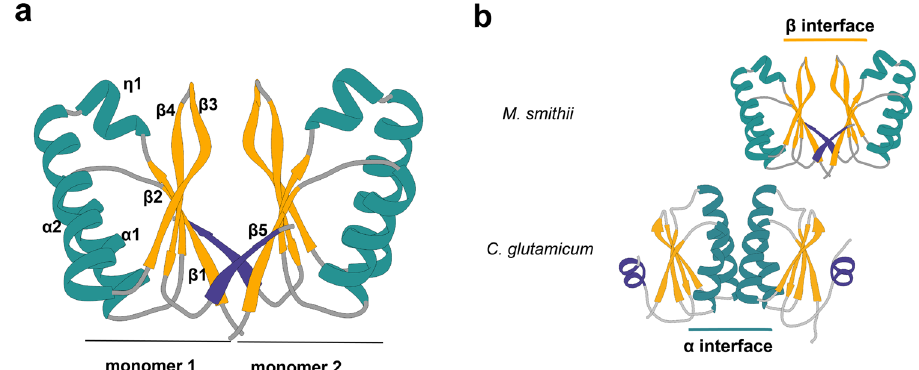
Fig. 3 Structural characterization of Ms SepF core . a Crystal structure of the Ms SepF dimer composed of two identical monomers, color-coded according to secondary structure (helices, green; strands, yellow). Each protomer consists of a 5-stranded β -sheet fl anked by 2 α -helices and a helical turn ( η 1). In each protomer, the C-terminal strand β 5 (in purple) forms part of the opposing β -sheet. b Comparison of functional SepF dimer interfaces in Bacteria and Archaea, as de fi ned by the complexes with FtsZ. The α interface has only been found in the crystal structures of bacterial SepF dimers such as those of C. glutamicum (PDB 6SCP, shown in the fi gure) and B. subtilis (PDB 3ZIH), whereas the β interface has been found in all Archaeal structures (e.g. Archaeoglobus fulgidus (PDB: 3ZIE), Pyrococcus furiosus (PDB: 3ZIG), see also Supplementary Fig. 8). The C-terminal secondary structure element of the crystal structures ( β 5 in M. smithii and α 3 in C. glutamicum ) are depicted in